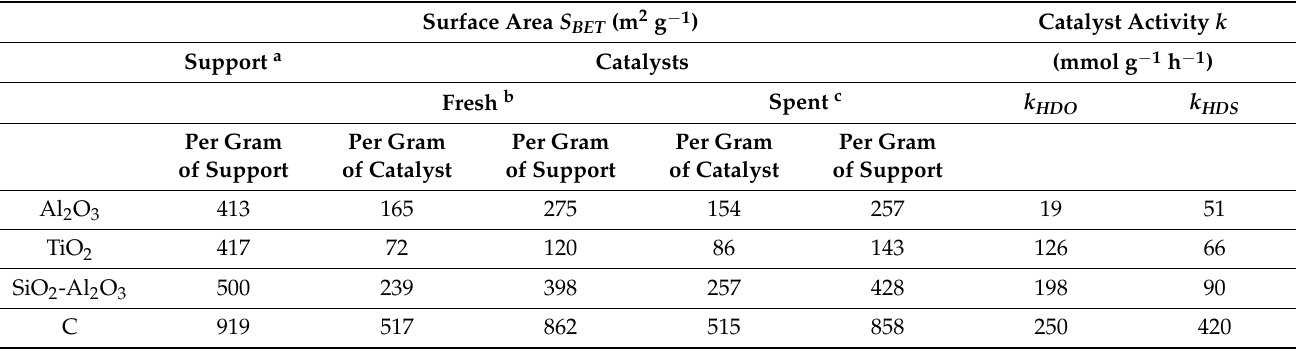
Table 1. The comparison of selected textural and catalytic